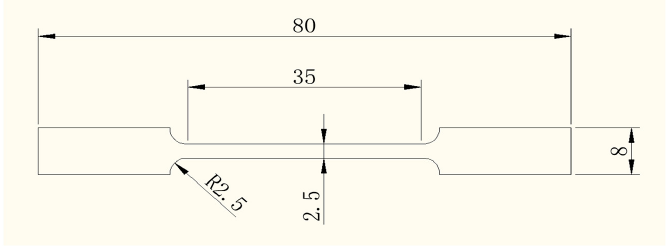
Figure 9. The sample size of the tensile test (unit: mm).